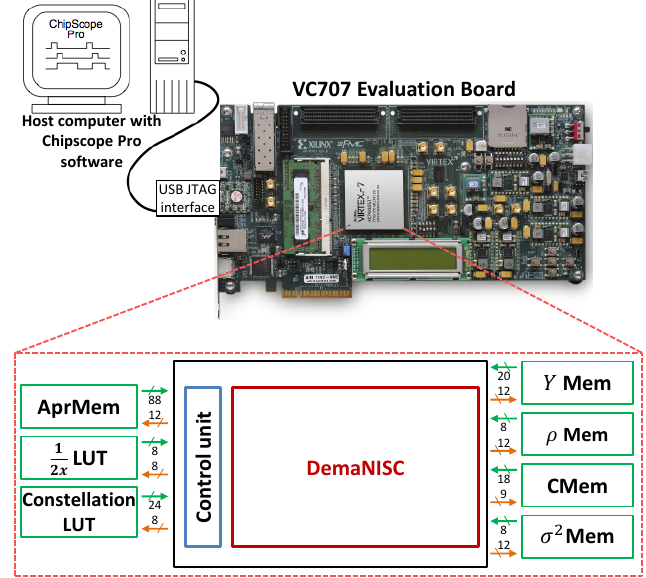
Figure 15. NISC-based demapper architecture on-chip